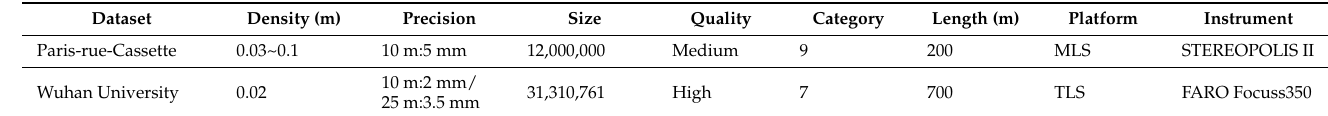
Table 2. Characteristics of the two datasets.